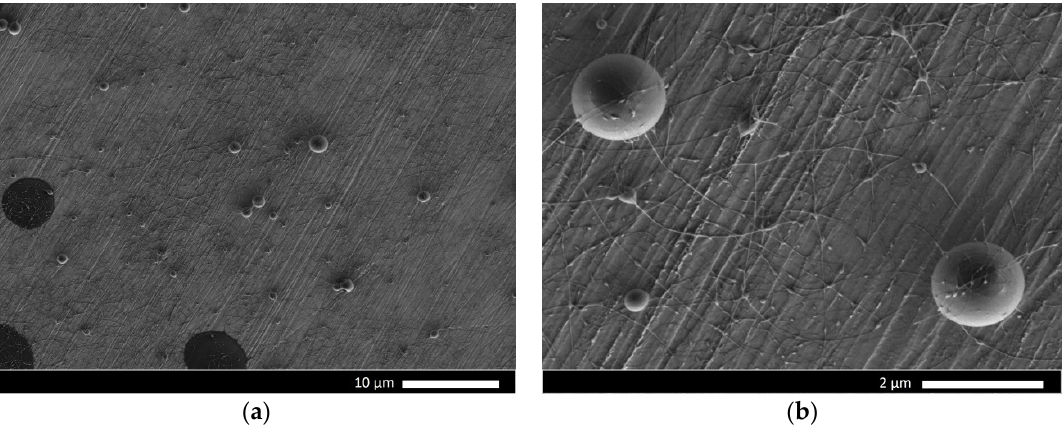
Figure 12. SEM photomicrographs of nanoparticles electrosprayed from the hyaluronic acid solutions with concentration 15.0 mg/mL under 30 kV: ( a ) magnification 4000×; ( b ) magnification 25,000×.